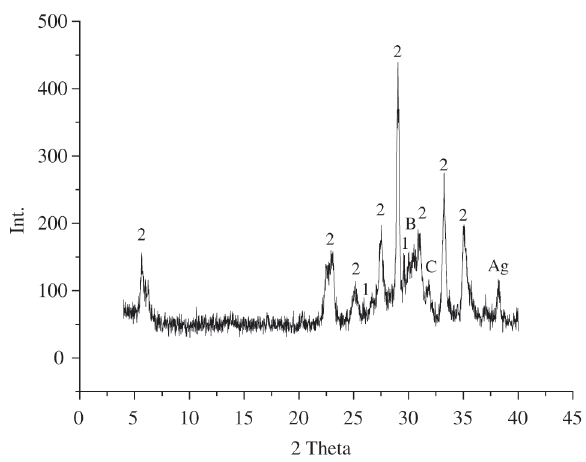
Figure 3. Diffractogram of the bulk Bi by PMR. 2: Bi-2212, 1: Bi-2201, B: 91150ss, C: 14:24-AEC, Ag: silver.